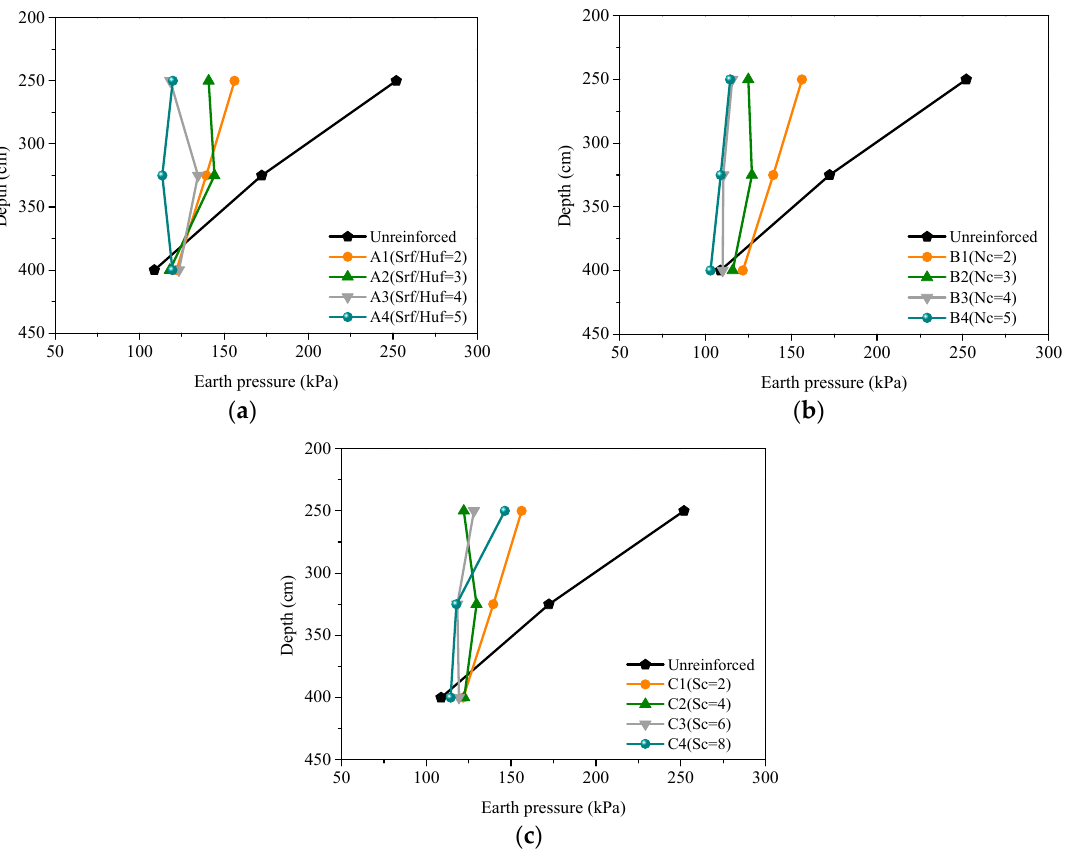
Figure 5. The vertical earth pressure under different reinforced factors: ( a ) embedded ratio; ( b ) number of reinforced layers; ( c ) interval of reinforced layers.